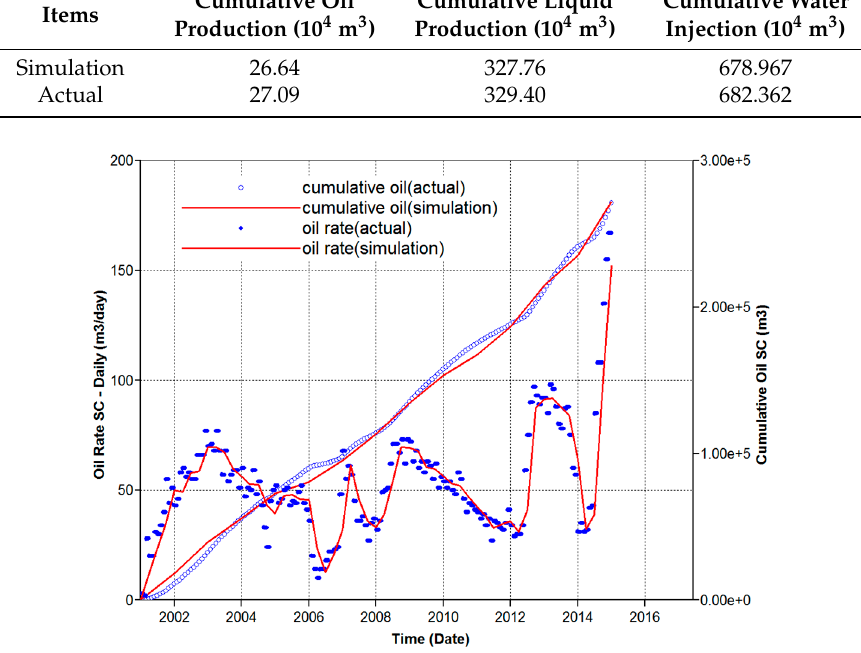
Figure 3. Fitting curve of the oil production in the experimental area.